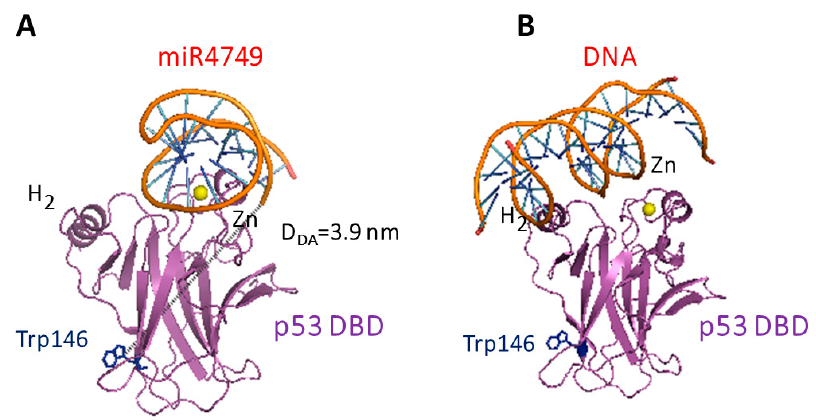
Figure 7. ( A ) Best model for the complex between DBD and miR4749. The distance D DA between Trp146 and the 5 ′ end of miR4749 and the center of the aromatic rings of the lateral chain of Trp146 of DBD (black dashed line) is reported. ( B ) X-ray structure of DBD (chain B) complexed with DNA (1 TUP PDB entry).